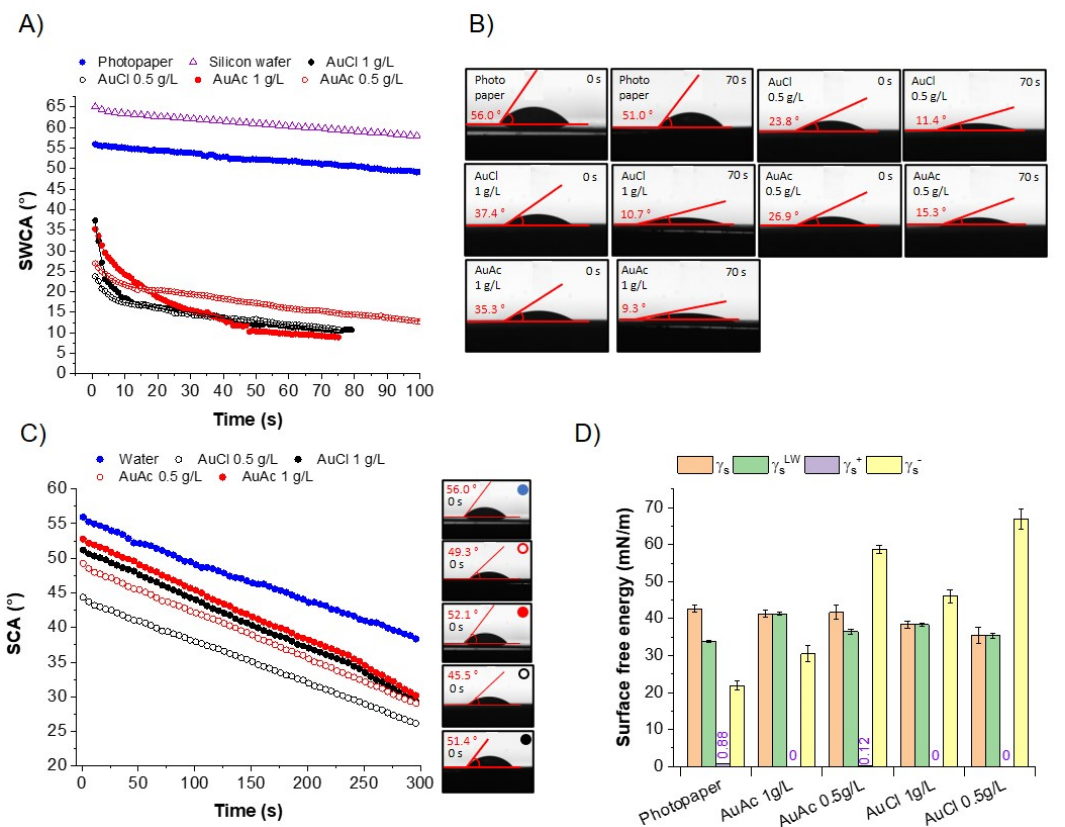
Figure 8. OCA: Optical contact angle measurements of inkjet-printed patterns from gold inks. ( A ) Static contact angle of the water (SWCA)(t) on neat photo paper and inkjet-printed patterns of gold inks (lines represent polynomial fits; order = 9); ( B ) drop images of water from SWCA(t) measurements at the time of contact (0 s) and after 70 s; ( C ) static contact angles (SCA)(t) of water and gold inks on photo paper; and ( D ) surface free energy calculations of the inkjet-printed patterns from gold inks using the Good, van Oss, and Chaudhury (GvOC) approach.